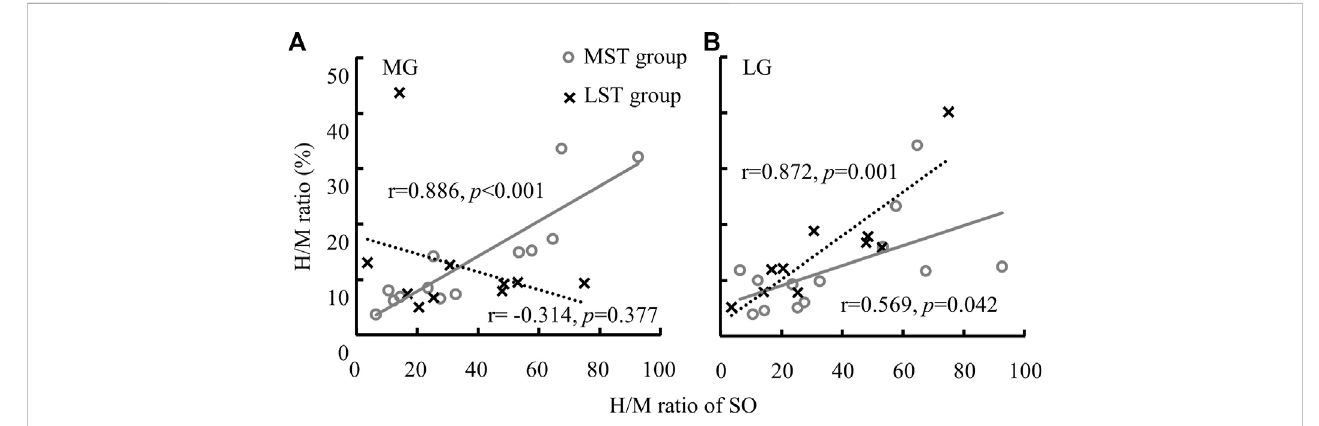
FIGURE 3 Asigni fi cantlinear relationshipbetweentheH/MratioofSOandMG[ (A) onlyinMSTgroup] andthelinear relationships betweentheH/MratioofSOand LG [ (B) among both MST and LST groups] were